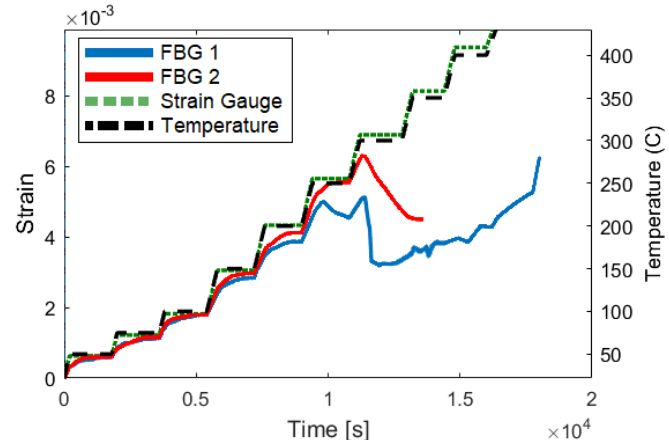
Figure 21. Elevated-temperature testing of two UAM-embedded FBG sensors. The strain measurements of two coupons with embedded FBG sensors and strain gauges is shown using the left scale. The temperature trace (black line) follows the scale on the right.